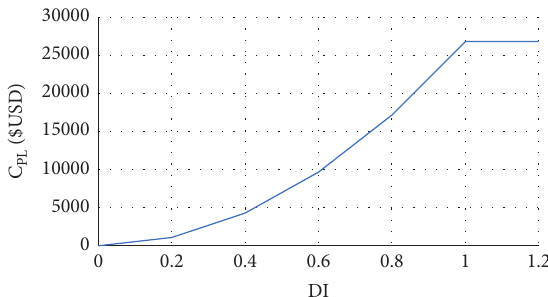
Figure 6: Cost of Injuries per person as a function of the damage